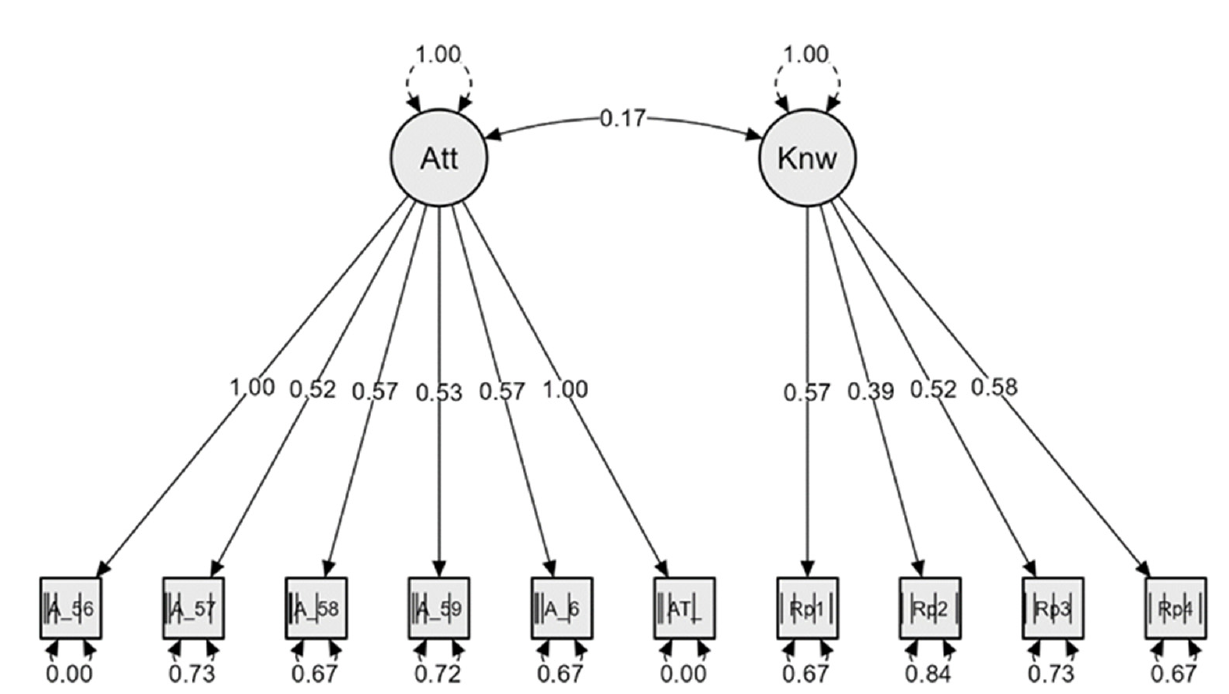
Figure 2. Factor loadings for the problem-solving area. Factors loadings for the area of information literacy ranged from 0.43 to 0.83, which is considered acceptable and significant (Figure 3).